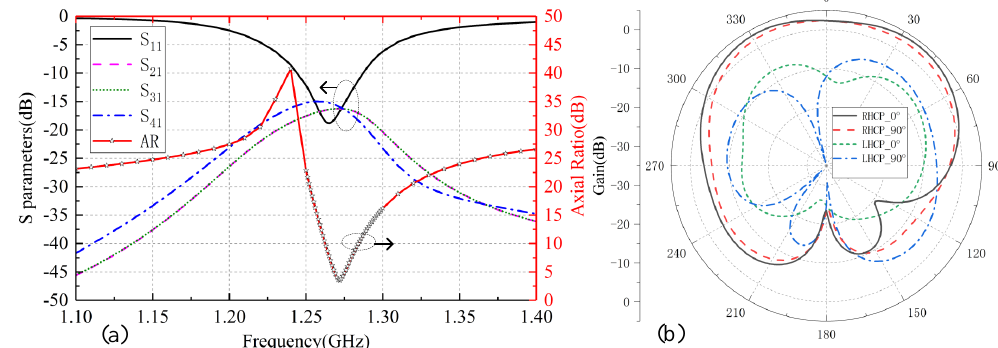
Figure 2. The ( a ) S parameters and axial ratio and ( b ) radiation patterns of the BDS antenna without magnetic metamaterials